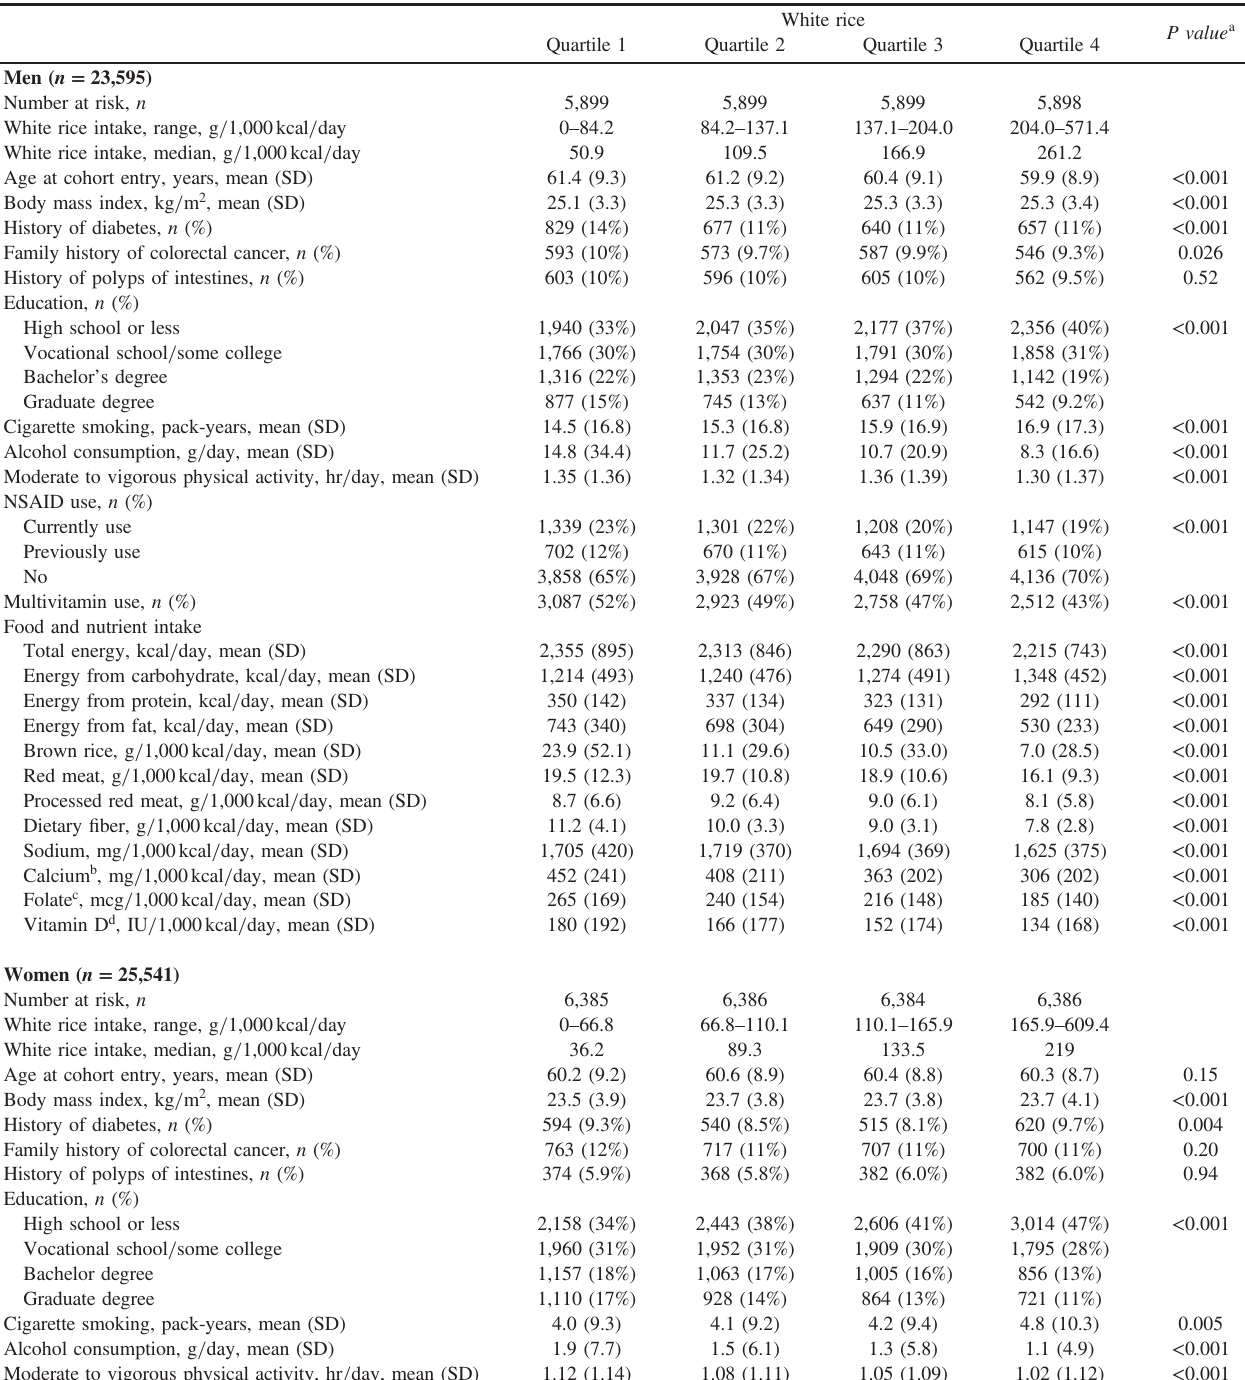
Table 1. Baseline characteristics for Japanese men and women according to white rice consumption